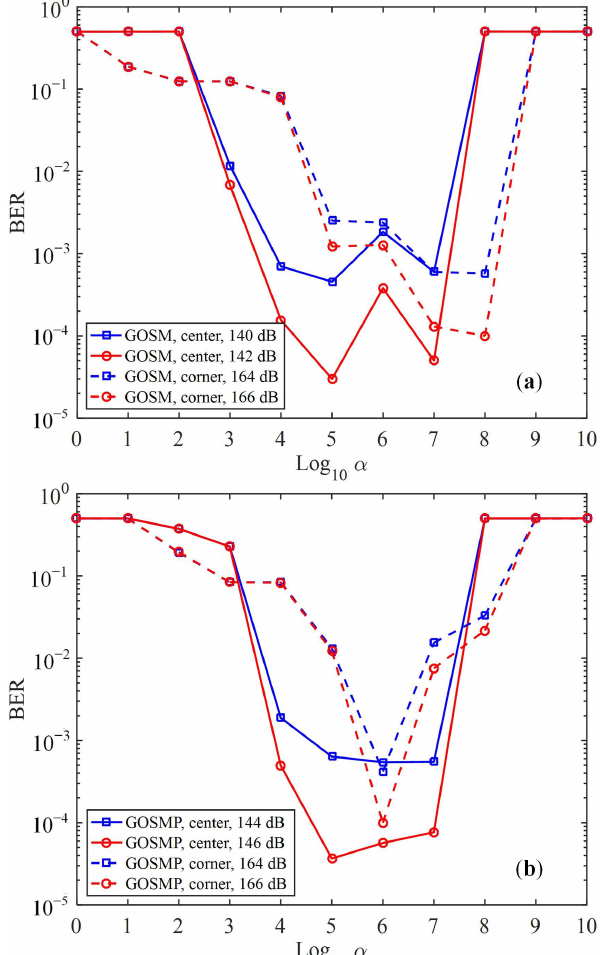
Figure 7. BER vs. log α of the proposed CSI-free DNN detector for ( a ) GOSM and ( b ) 10